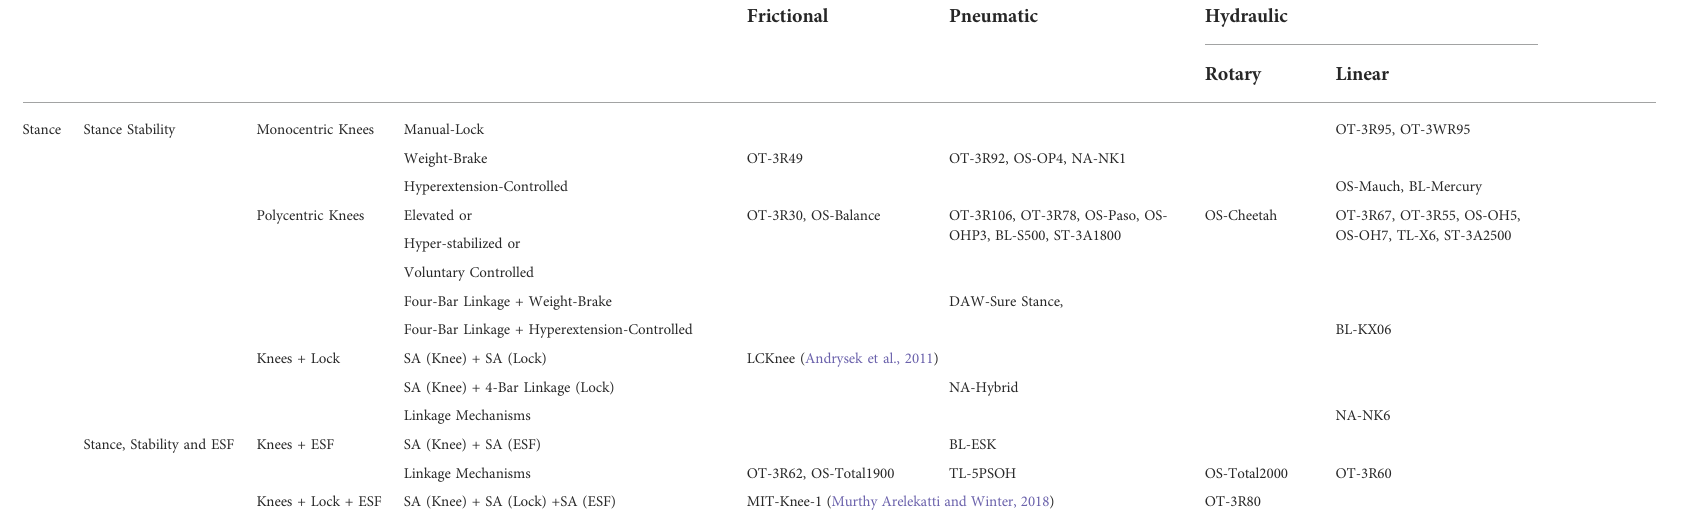
TABLE 2 Passive prosthetic knees based on walking